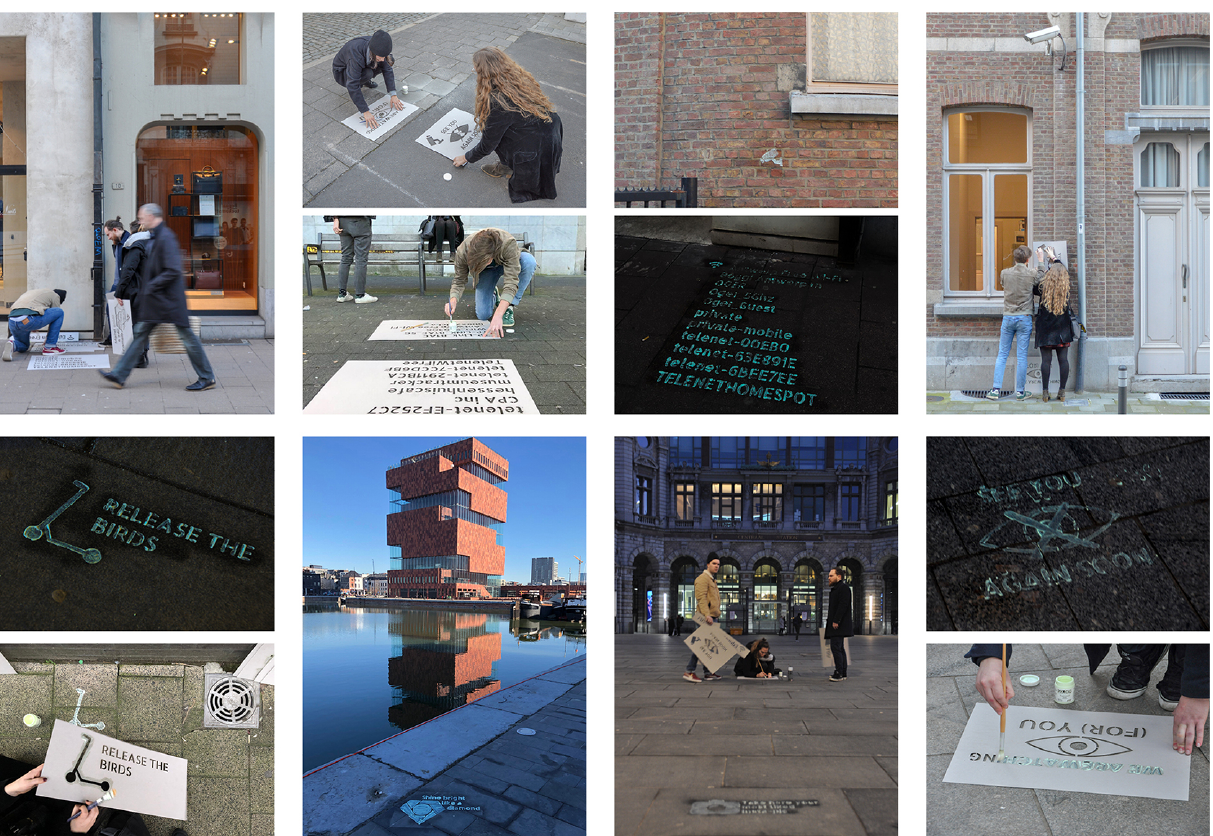
Figure 2. Process and effect of interventions in the space of the ‘Analogue City’ that were painted with fluorescent paint and as such became more present after sunset. The street paintings served as hyperlinks connecting the data-points of the ‘Analogue City’ map with their actual place. Source: The ‘Analogue City,’ IDW University of Antwerp 2019 students, and the